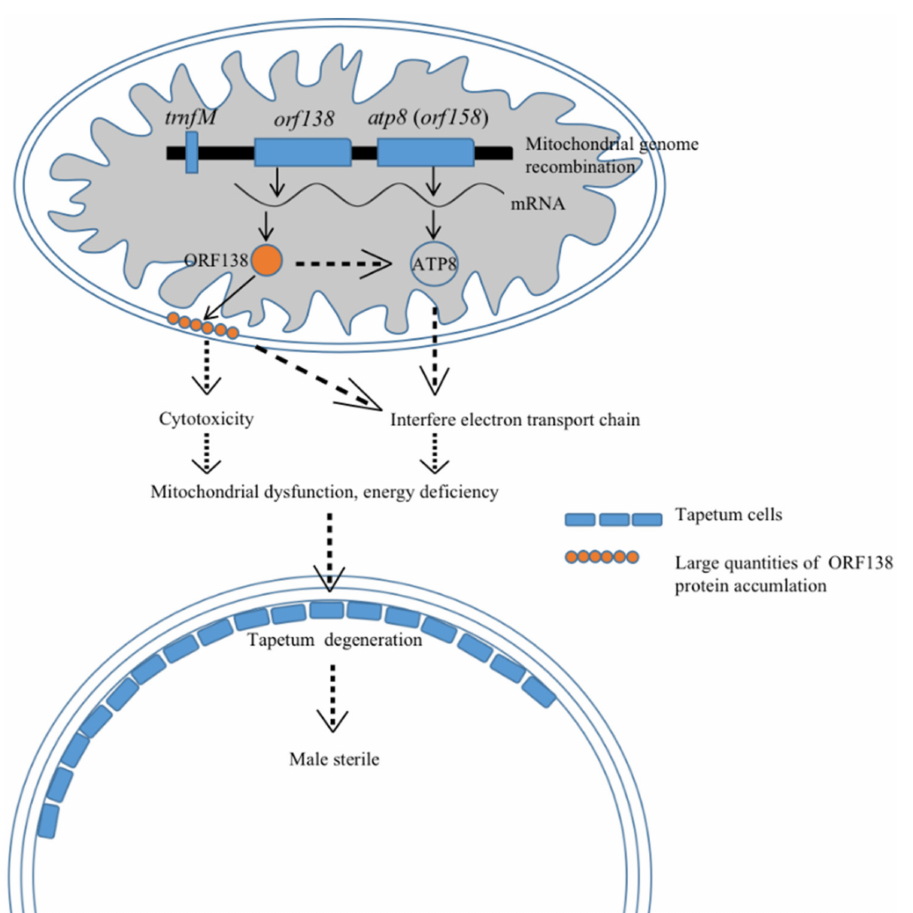
Figure 2. Model of the mechanisms of the Ogura CMS fertility restorer gene Rfo ( PPR-B